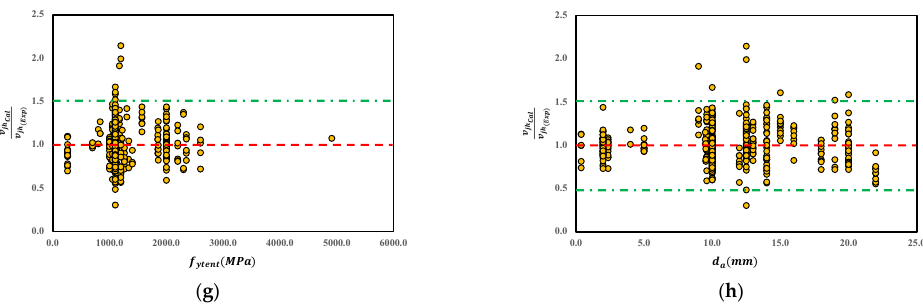
Figure 6. The predictive performance of the proposed steel fiber reinforced (steel fiber reinforced concrete (SFRC)) concrete beam shear strength model based on the main parameters. ( a ) Beam Width ( b ) Beam depth ( c ) Longitudnal Reinforcement ( d ) Span-to-Depth Ratio ( e ) Concrete Copmressive Strength ( f ) Fiber Volume ( g ) Fiber Tensile Strength ( h ) Diameter of